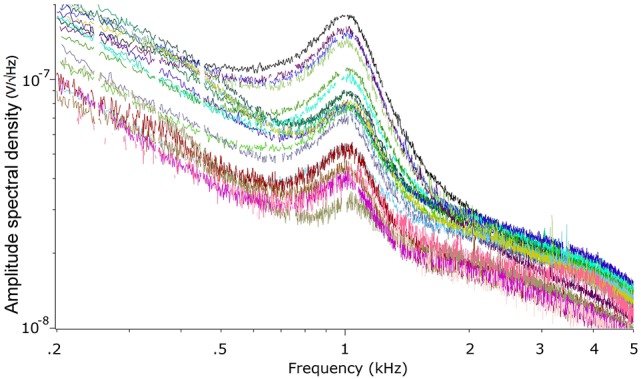
Power spectrum of the tympanic electric noise. Each colored curve represents one different subject. Note the presence of a broad peak in all subjects around 1,000 Hz. The missing points in the curves were eliminated by the denoise procedure (described in the Methods section).